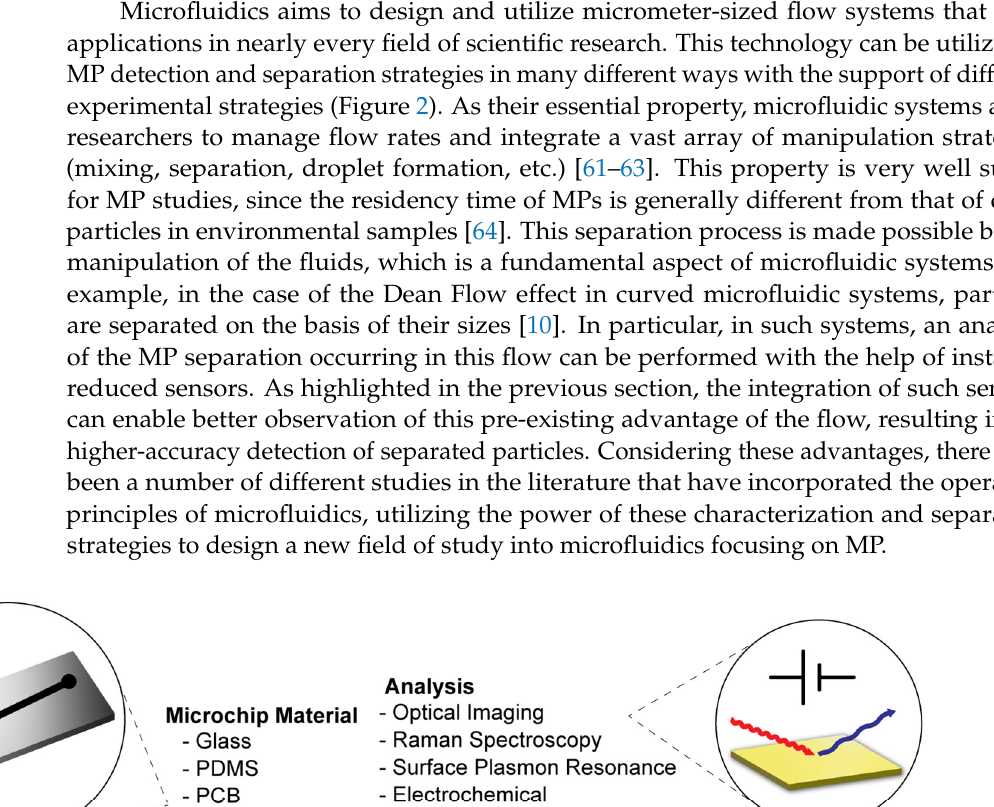
Figure 2. The versatility and modularity of microfluidic strategies for MP research.